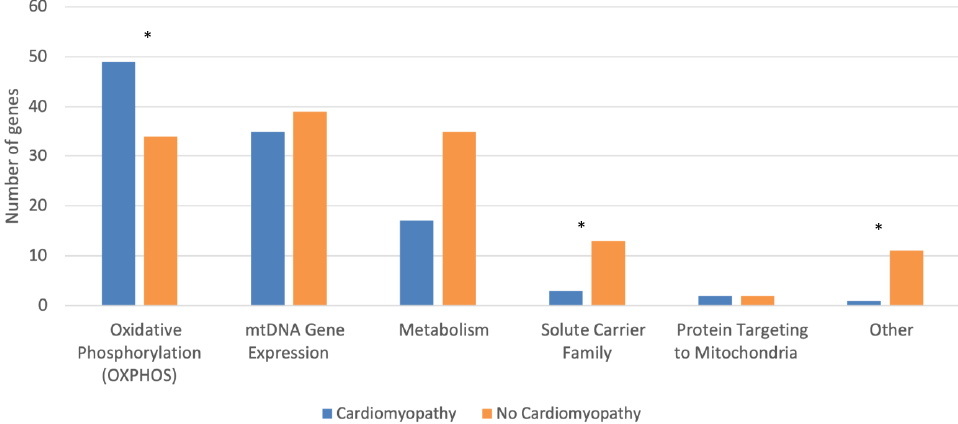
Figure 1. Mitochondrial Disease-Causing Genes Classified by the Presence of Cardiomyopathy and Protein Function Affected, as Defined by Mootha and Colleagues [25]. * indicates p < 0.05. Upon further subanalysis of gene categories with more than five mitochondrial dis- eases with and without cardiomyopathy, there was a difference in the prevalence of dif-